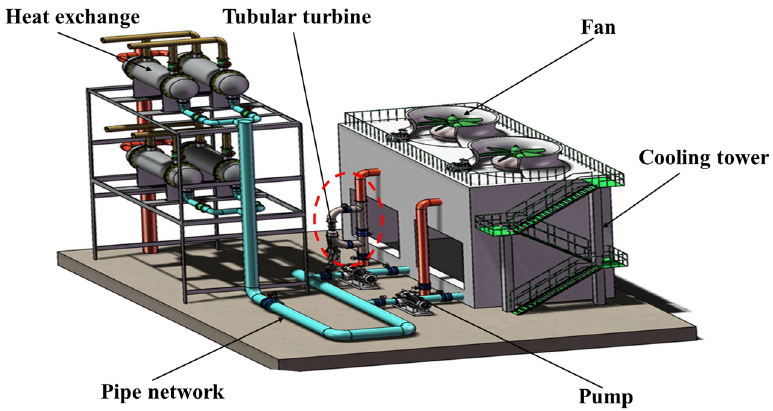
Figure 1. Recovery of the CCWS surplus back pressure energy with a tubular turbine.